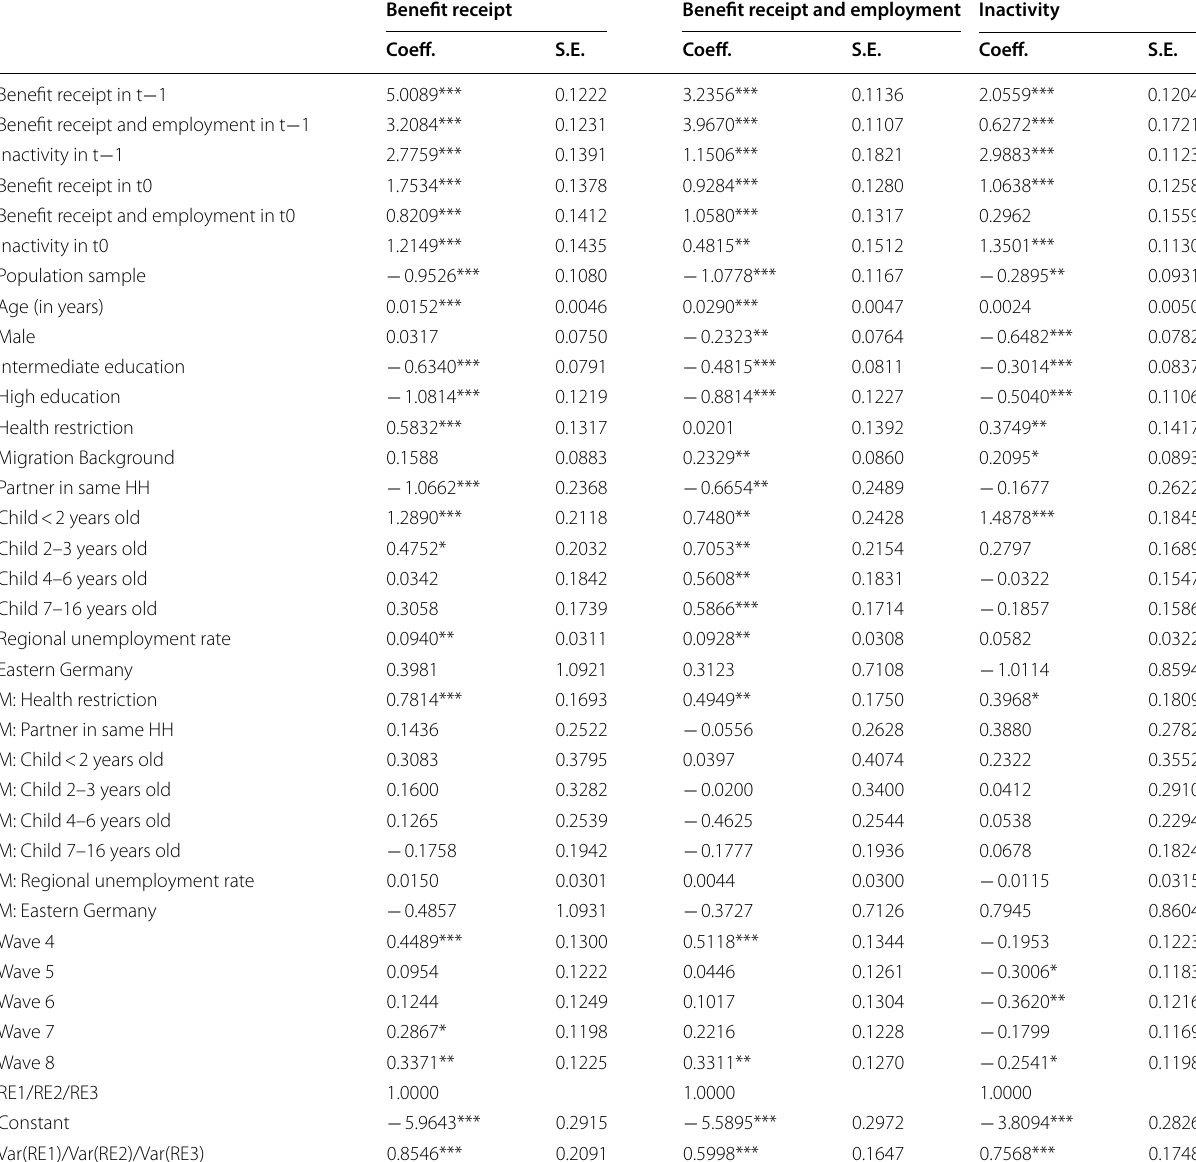
Table 10 Multinomial logit regression results